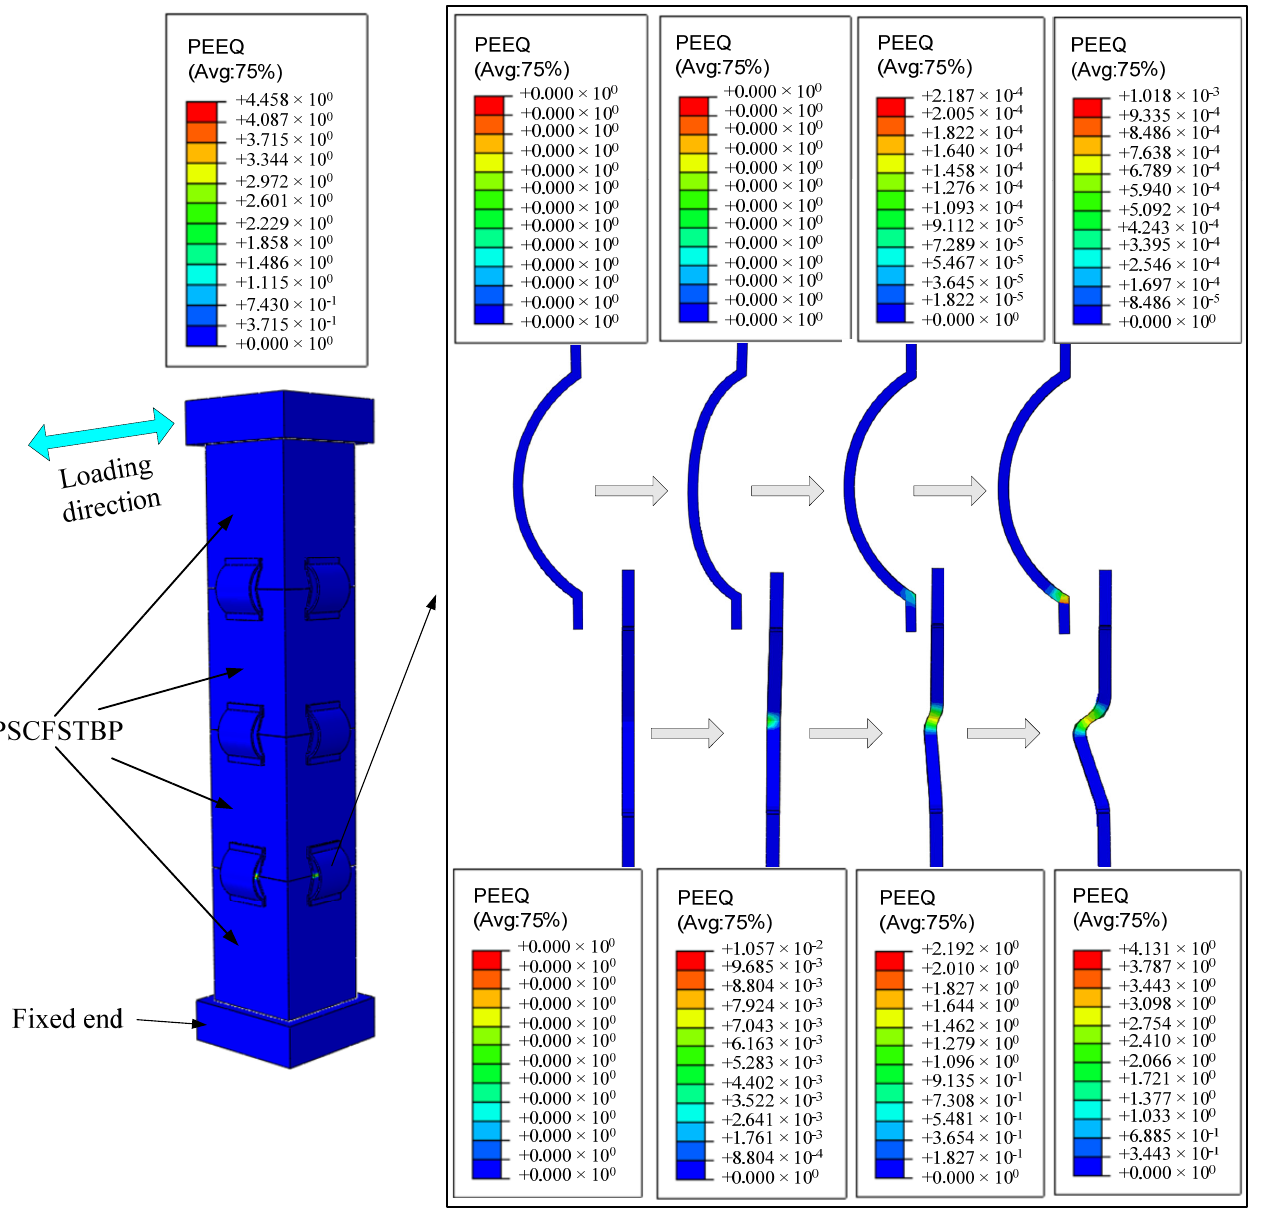
Figure 19. PEEQ (equivalent plastic strain nephogram).